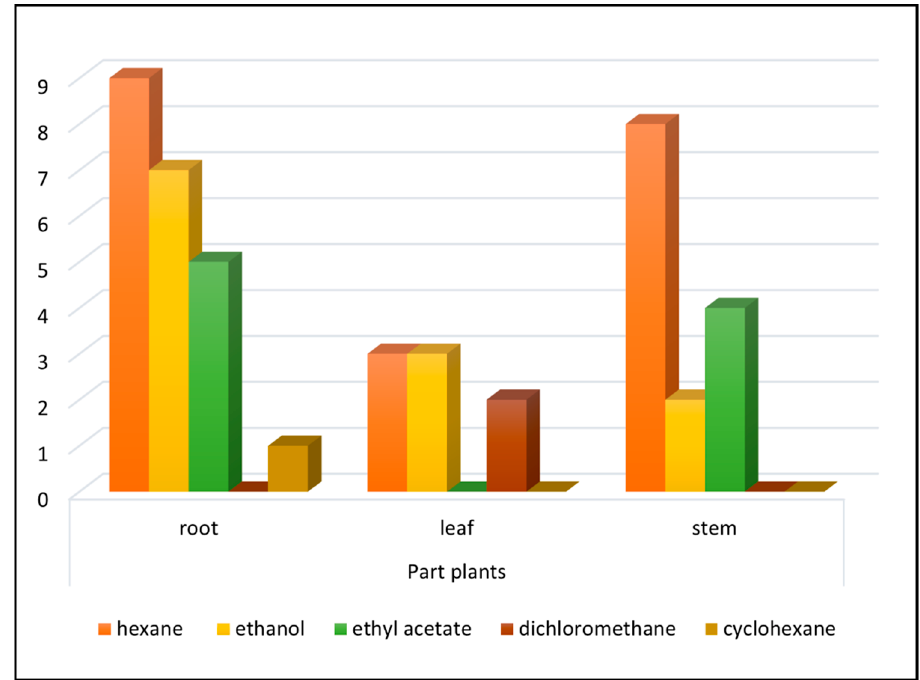
Figure 2. Plant parts and extraction solvents of the 44 active extracts selected for dose-response determination.